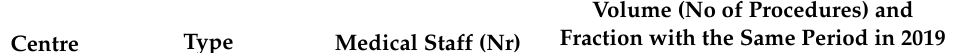
Table 1. Characteristic of the centers involved in the present